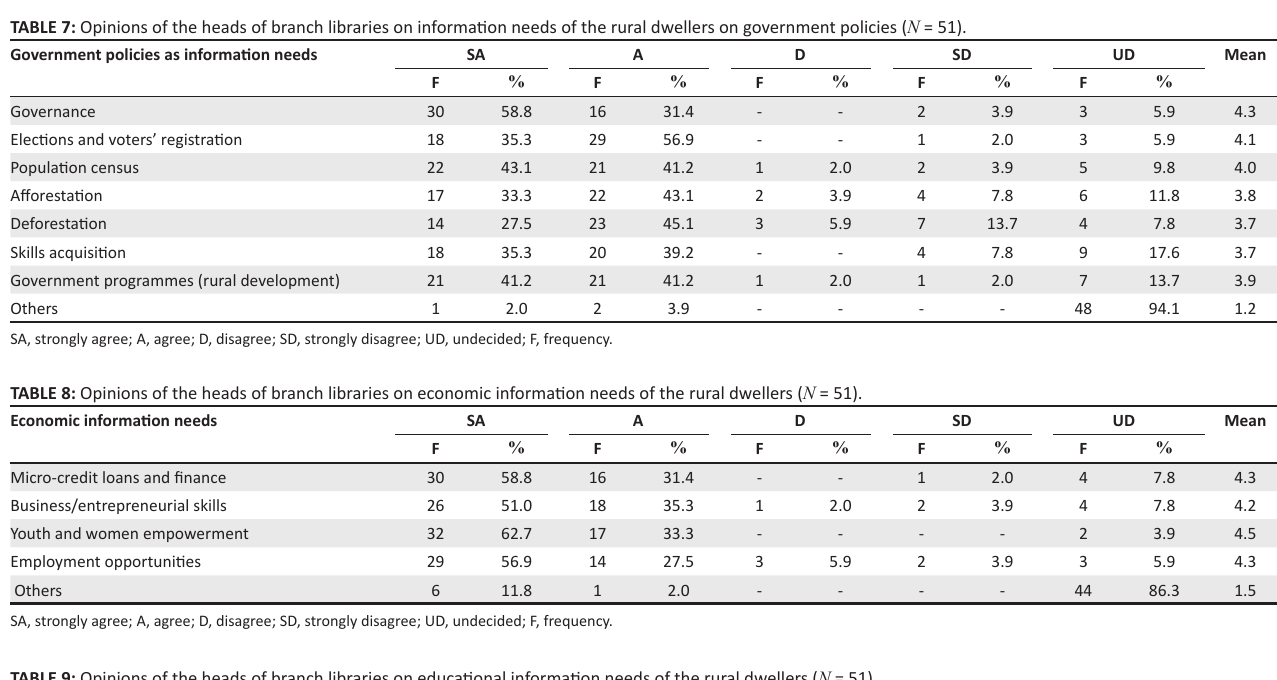
TABLE 9: Opinions of the heads of branch libraries on educational information needs of the rural dwellers ( N = 51). Educational information needs